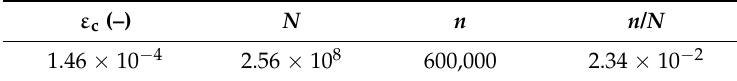
Table 6. Subgrade rutting verification—asphalt pavement.